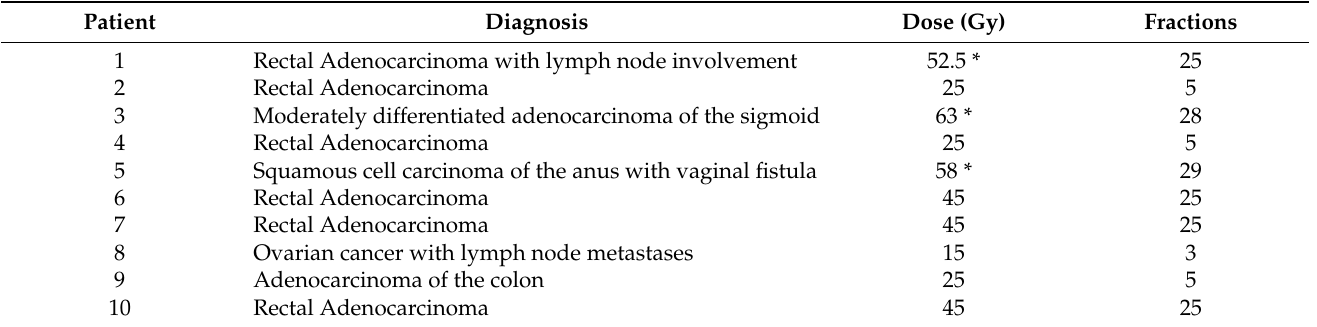
Table 1. Diagnoses, plan dose, and total fractions for the patients chosen for this study. An asterisk signifies the dose includes an SIB target which was subsequently removed for the purposes of this study.